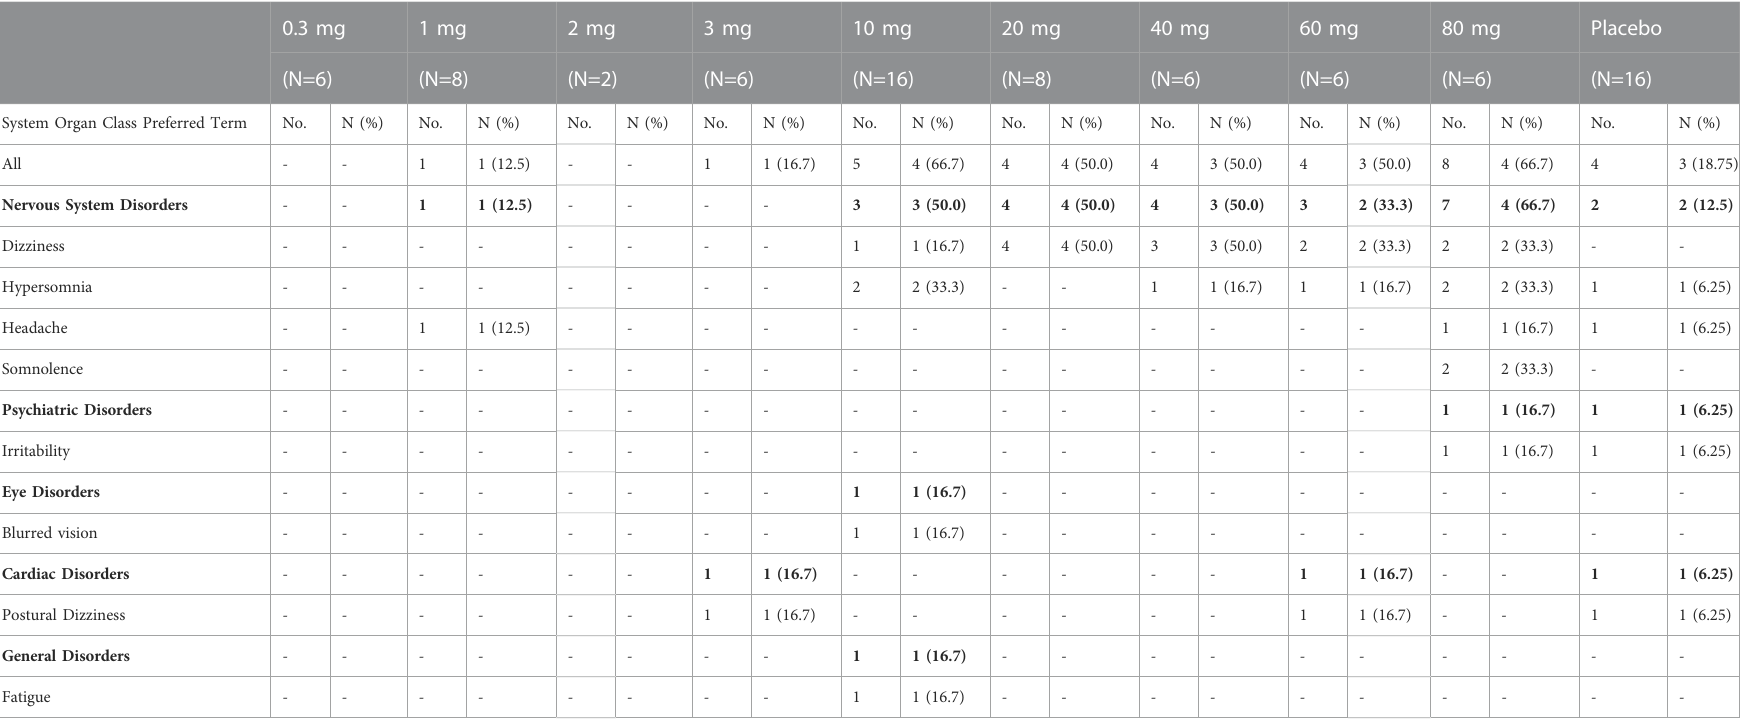
TABLE 2 Drug related treatment emergent adverse events